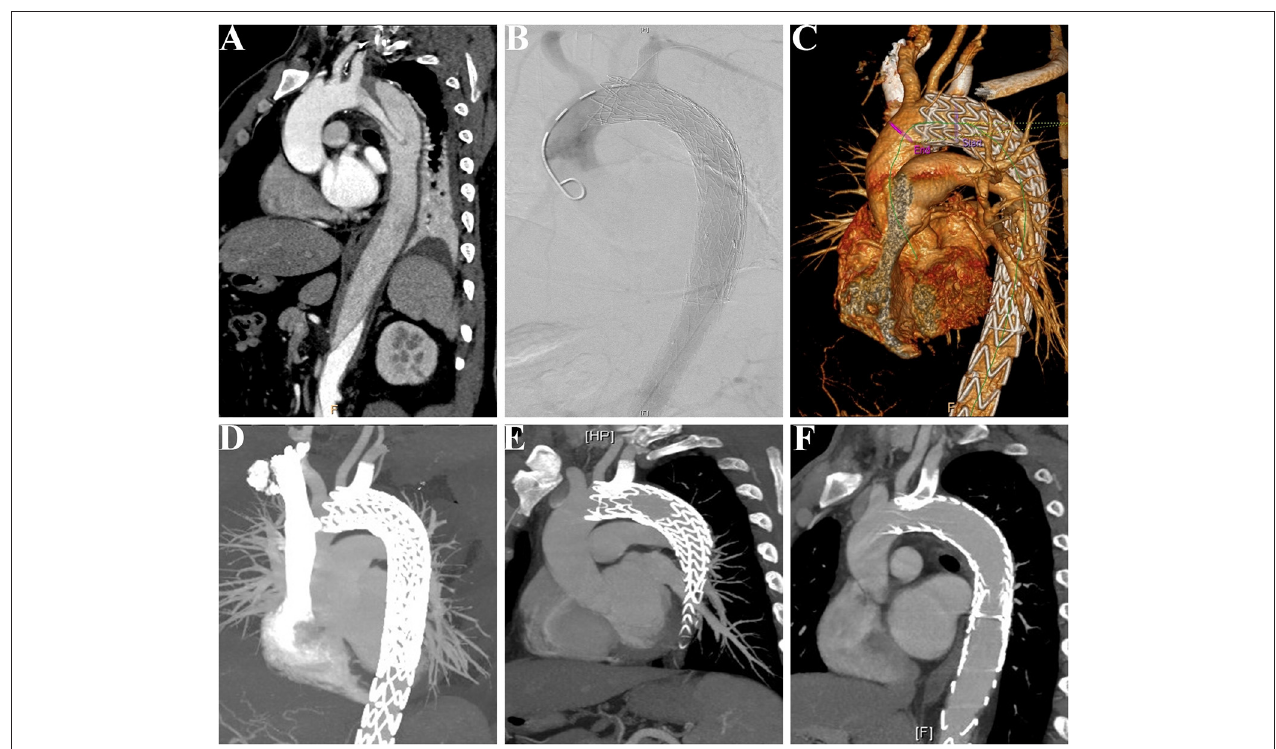
FIGURE 5 | Patency of the LSCA was followed-up in a patient receiving the MCPF technique. (A) Preoperative CTA showed that a patient suffered from thoracic aortic dissection, which involved the LSCA. (B) Intraoperative aortogram demonstrated that the LSCA was revascularized and false lumen was excluded. (C) Before discharge, CTA was conducted to confirm the patency of the LSCA and exclusion of false lumen. (D) CTA at follow-up of 6 months. (E) CTA at follow-up of 12 months. (F) CTA at follow-up of 24 months. LSCA, left subclavian artery; MCPF, mini-cross prefenestration; CTA, CT